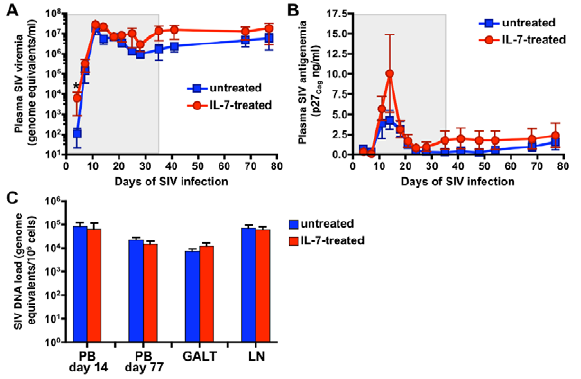
Figure 2. Effect of IL-7 treatment on SIV replication. Mean levels ( 6 SEM) of SIV plasma viremia (A) and p27 Gag antigenemia (B) in untreated (blue) and IL-7-treated (red) animals. No significant differ- ences were observed between the two groups of animals, with the only exception of SIV plasma viremia on day 4 post-infection, when IL-7- treated animals showed higher levels compared to untreated controls (indicated by the asterisk; p , 0.05, by Wilcoxon rank sum test). The grey-shaded area indicates the IL-7-treatment period. (C) Mean number of genome equivalent copies ( 6 SEM) of SIV proviral DNA in mononuclear cells from peripheral blood (days 14 and 77 post- infection) and lymphoid tissues (GALT, days 14–16; axillary lymph nodes, days 25–27 post-infection). No significant differences were observed between the two groups of animals, p . 0.05 by Wilcoxon rank sum